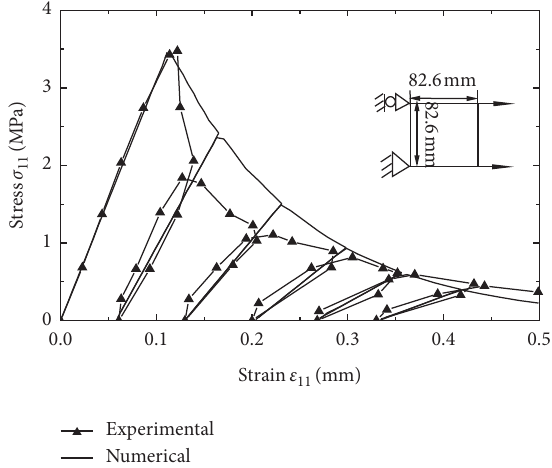
Figure 5: Cyclic tensile stress-strain curve of concrete.